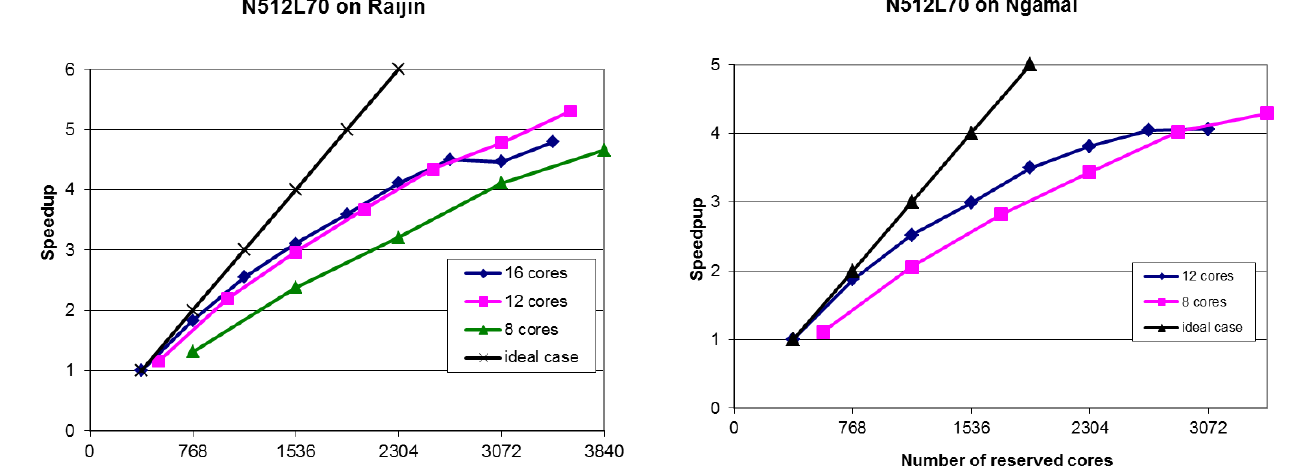
lfs setstripe -s 8M \